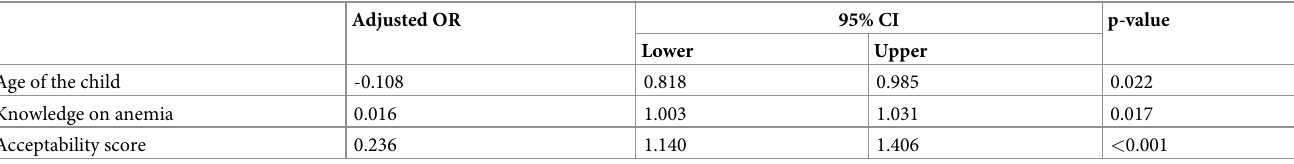
Table 6. Multivariate analysis of factors affecting